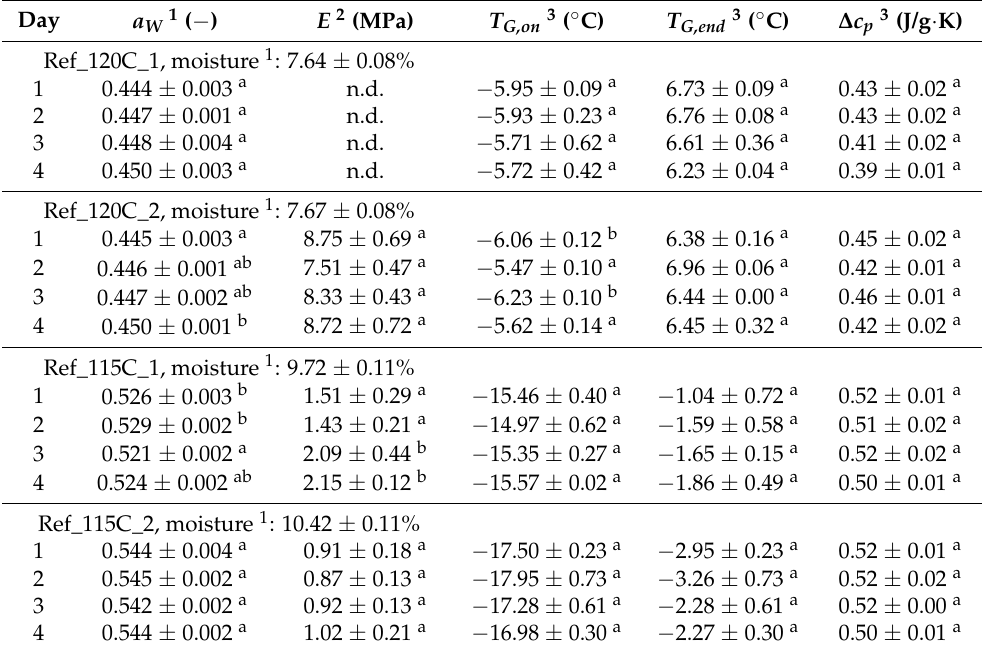
Table 1. Results from storage experiments. Water activity a W , Young’s modulus E , glass transition onset, T G,on , and endpoint temperature, T G,end , and change in specific heat capacity ∆ c p measured over four days in 24 h increments. Mean values with different superscripts (a, b, ab) within a parameter and sample indicate statistical difference ( p <